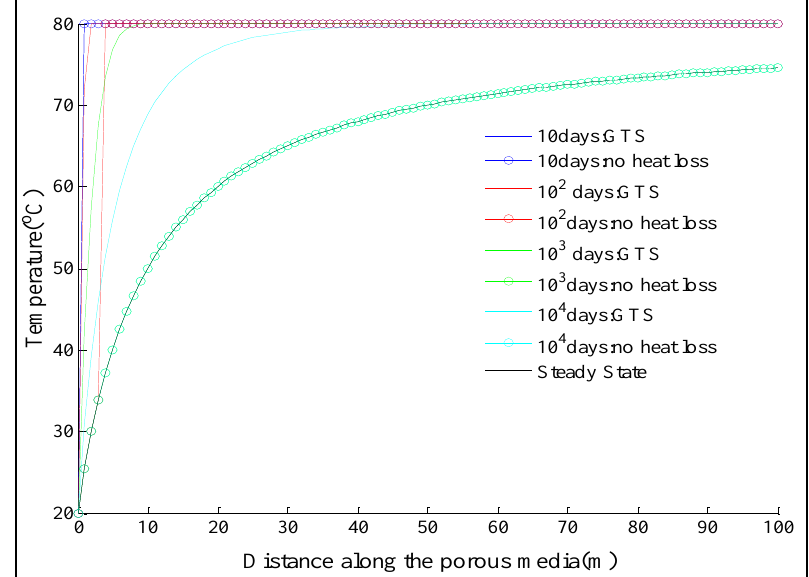
Figure 6. Temperature distribution plots in the geothermal aquifer at different injection times for the negligible conduction case with and without heat loss.